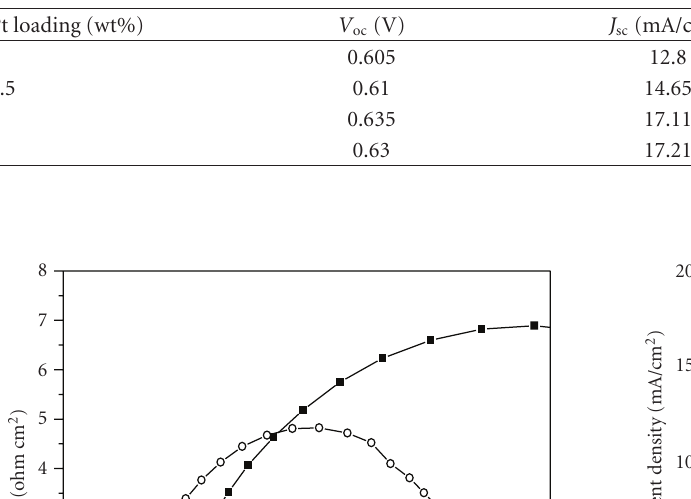
Table 2: The open-circuit voltage, the short-circuit current density, the fill factor, and the overall conversion e ffi ciency of DSCs using the Pt/MC counter electrode with di ff erent Pt loading.